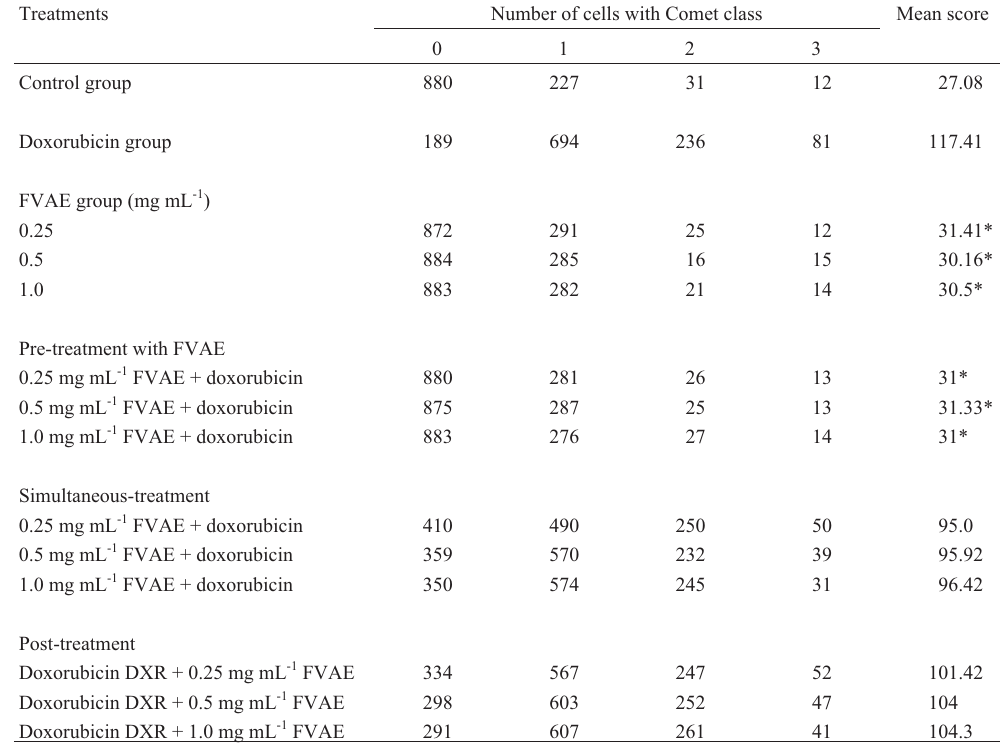
Table 2 - Comet assay scores for lymphocytes of 12 women treated with three different concentrations of Fucus vesiculosus aqueous extract (FVAE) and/or 15 μ g mL -1 of doxorubicin. For each treatment 100 nuclei were scored (n = 1200 cell/treatment).